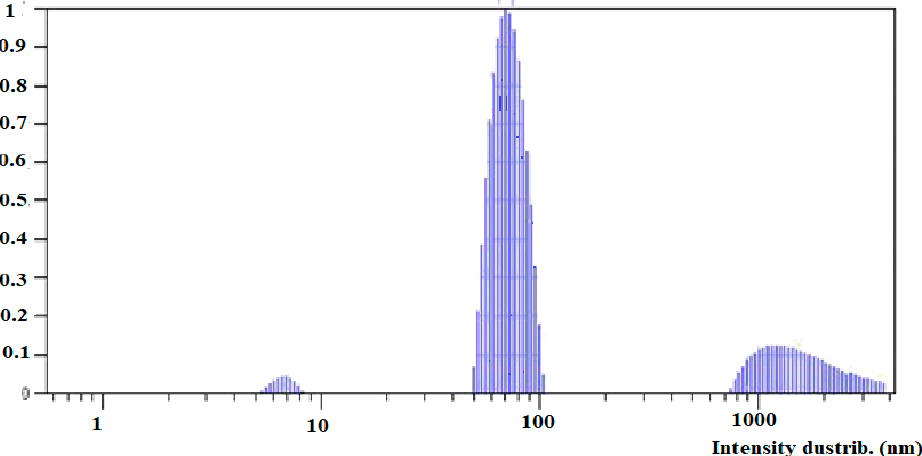
Figure 6. Silicon particle size distribution of aged colloidal solution.